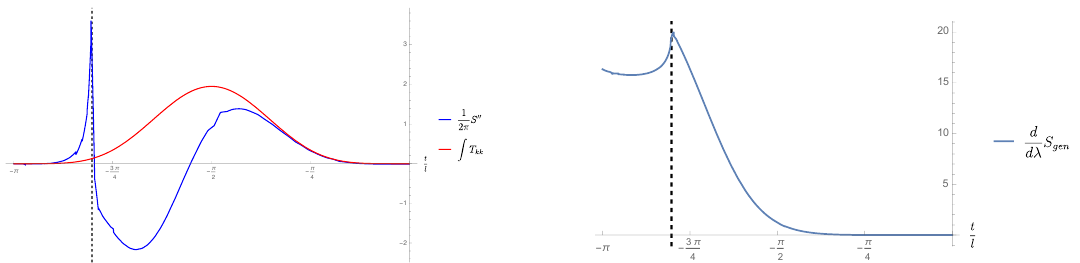
Figure 3 . Left: our test of the linearized QFC. Note that S 00 diverges when the topology of the causal surface changes. The time t = t (cid:3) of the transition is indicated by the vertical dashed line. The linearized QFC is violated in the neighborhood of this phase transition where S 00 = (2 (cid:25) ) p exceeds R dy hT kk . In the (cid:12)gure we have chosen r EH =‘ = 1 = 5, for which t (cid:3) (cid:25) (cid:0) 2 : 5. Right: the corresponding test of the GSL shows that the GSL is not